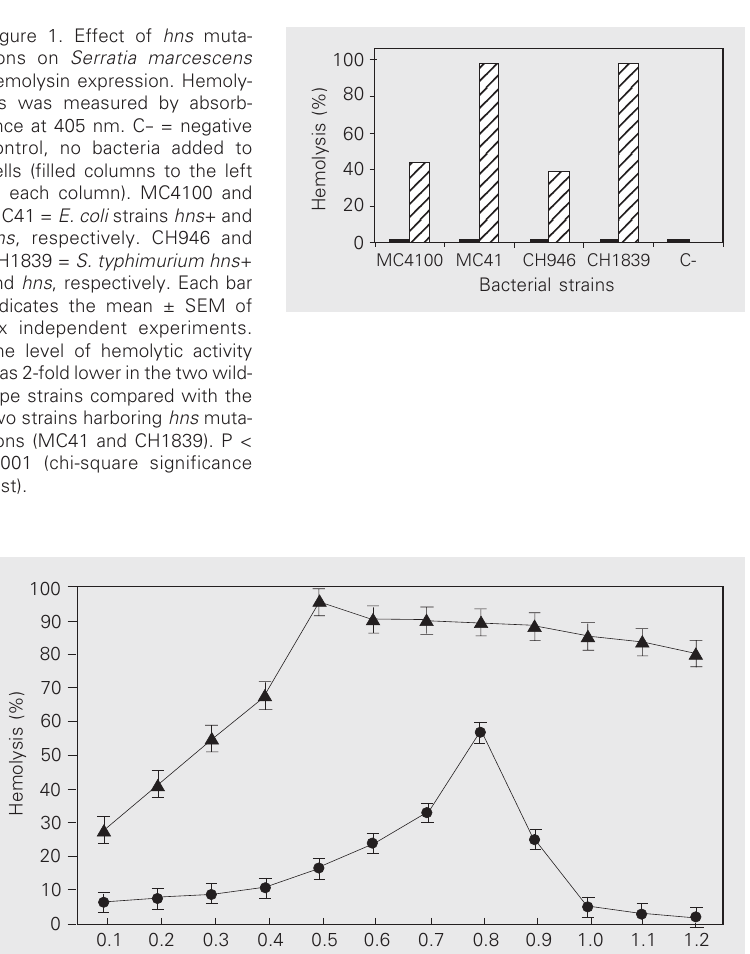
Figure 3. Effect of pH on hemo- lysis by an hns mutant. Hemoly- sis by Escherichia coli MC4100 (circles) and MC41 (triangles) was measured by absorbance at 405 nm. Each point indicates the mean ± SEM of four inde- pendent experiments. The he- molytic activity is highly re- duced at pH 5.0 in wild-type strains compared to hns mutant strains. P < 0.001 (chi-square significance test).